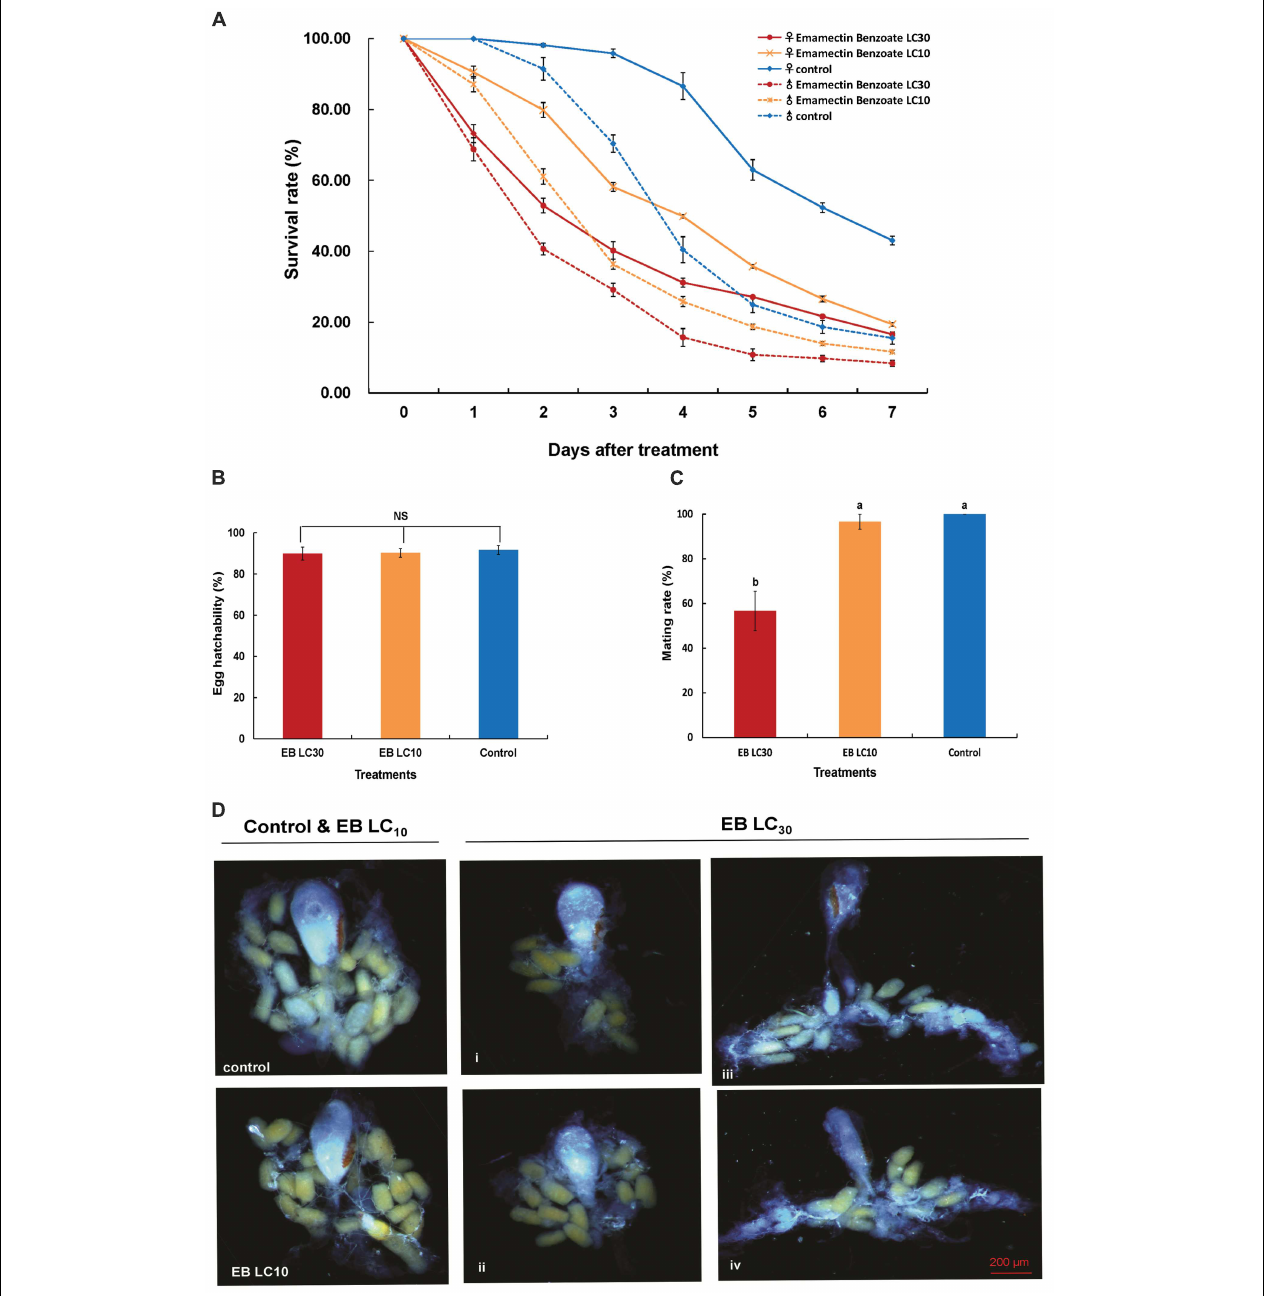
FIGURE 4 | Effects of emamectin benzoate (EB) exposure on the survival rate, egg hatchability, mating rate, and ovarian development in C. sinensis at the sublethal concentrations. The figure shows the survival rate (A) , egg hatchability (B) , mating rate (C) , and ovarian development (D) in C. sinensis at different treatments (LC 10 EB, LC 30 EB, and Control). The bars represent the average ( ± SD). Different lowercase letters above the columns indicate significant differences (Tukey’s test, P <